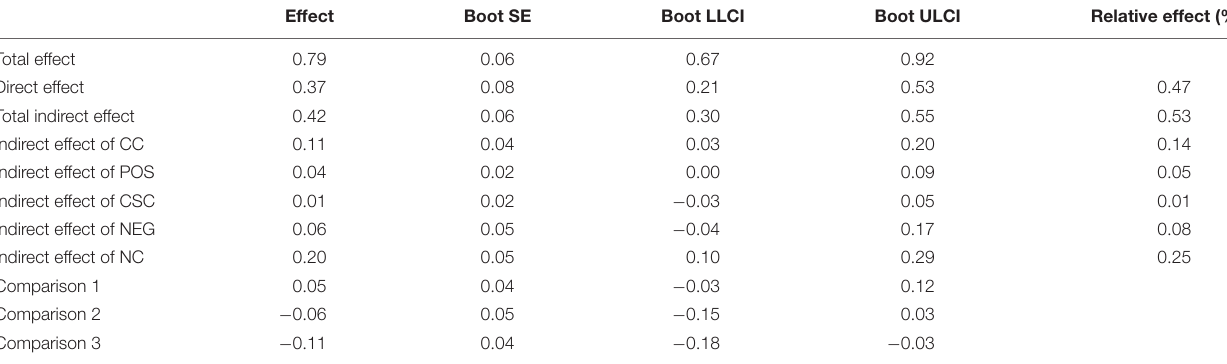
TABLE 3 | Total effect, direct effect, and indirect effect analysis of alexithymia and metacognition with its dimensions.